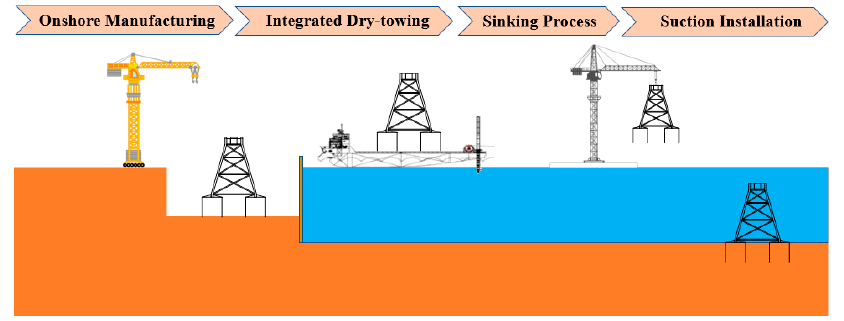
Figure 3. Manufacturing and dry-towing